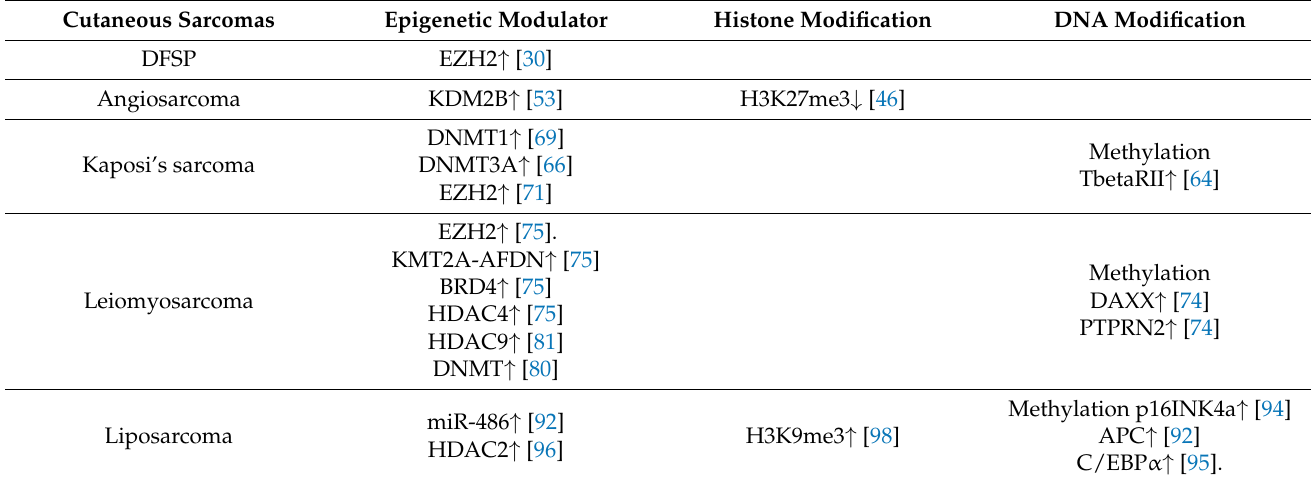
Table 1. Epigenetic modifications in skin